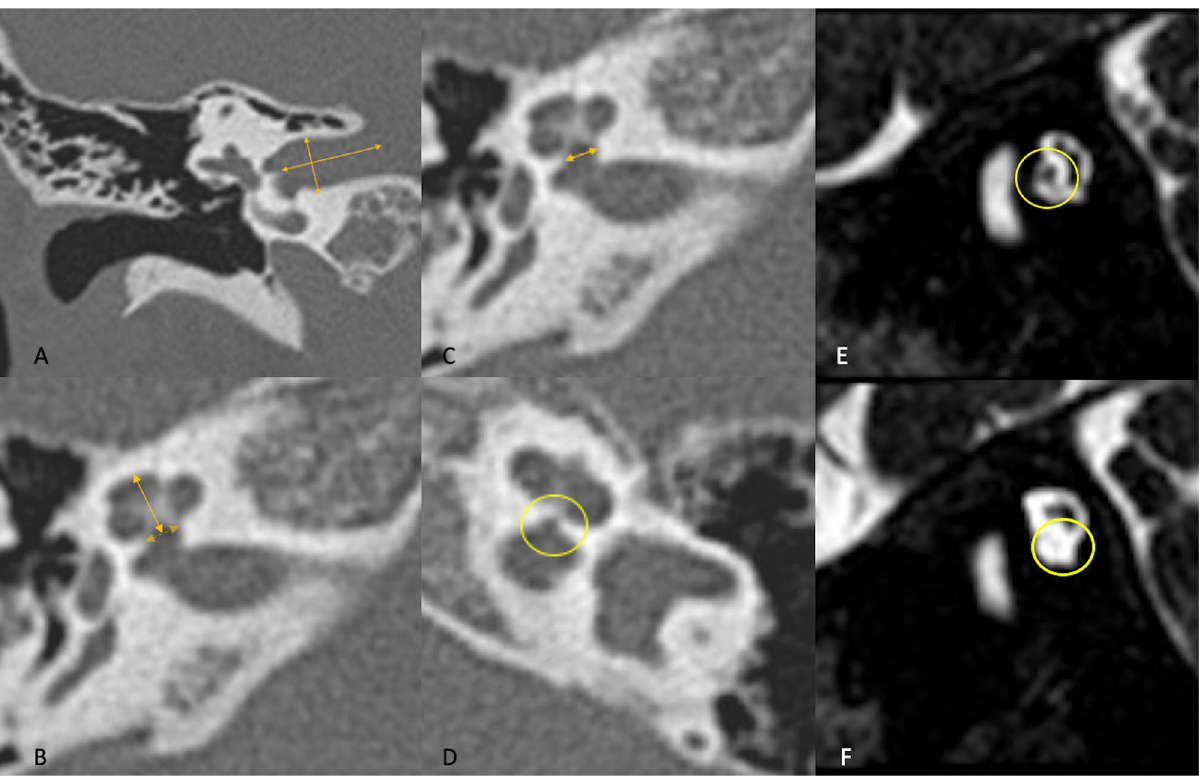
Figure 1. Inner ear CT scans with measures of inner auditory canal, cochlear height, cochlear aperture, and MR images of cochlear nerve. ( A ) Inner auditory canal (CT coronal view, right ear, normal); ( B ) Cochlear height (CT axial view, right ear, normal); ( C ) Cochlear aperture (CT axial view, right ear, normal); ( D ) Severe cochlear aperture stenosis (CT axial view, left ear); ( E ) Normal cochlear nerve, the bony canal is well visible and comparable with the facial nerve bony canal; (MR oblique-sagittal view); ( F ) Hypoplastic cochlear nerve, the bony canal is almost completely ossified, (MR oblique-sagittal view).